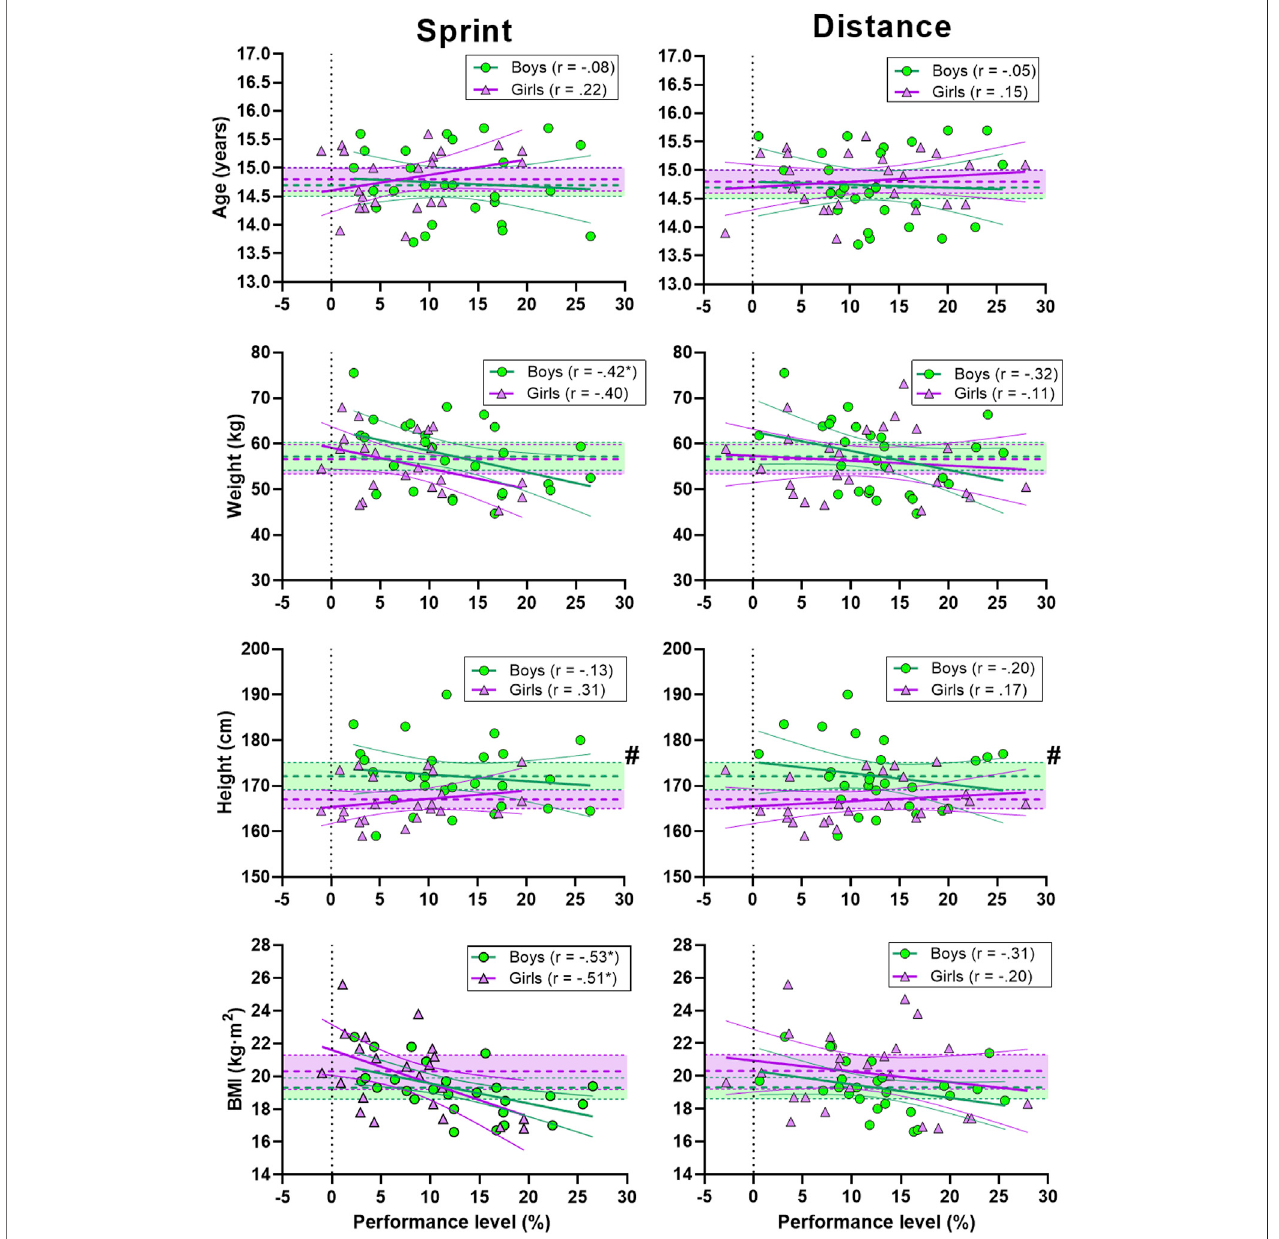
FIGURE5| Correlationbetweensprint(leftpanel)anddistanceperformance(rightpanel)andage,weight,heightandBMI.Greencirclesrepresentindividualvalues for the boys. Purple triangles represent individual values for the girls. Shaded areas with dotted lines in the middle represent mean ±95% con fi dence interval (CI) (green areafor theboys andpurple forthegirls). Thick andnarrowlinesrepresentthebest fi tregressionlineandthe 95%con fi dencebands (green linesfor theboys andpurple forthegirls).Seemethodsectionforexplanationoftheperformancelevel.*Correlationissigni fi cantatthe0.05level.#signi fi cantdifferencebetweenboysandgirls.